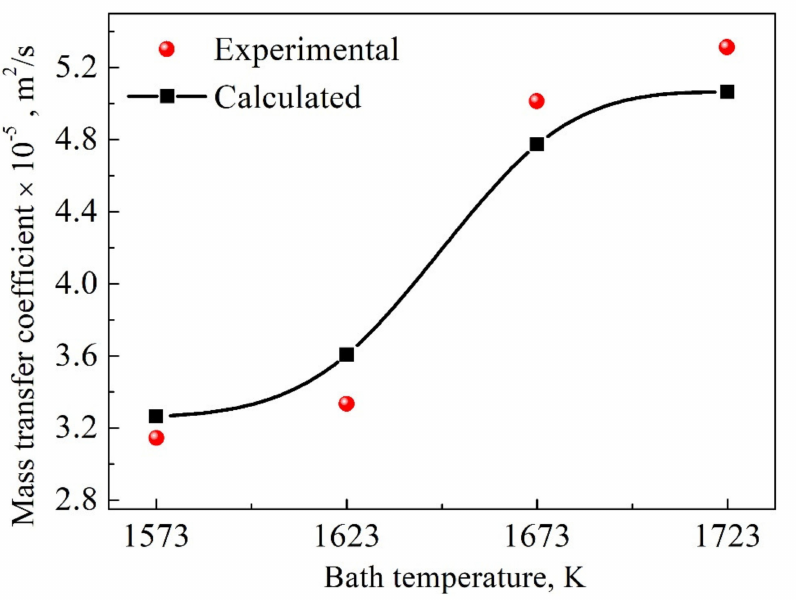
Figure 4. Validation of explicit function under natural convection